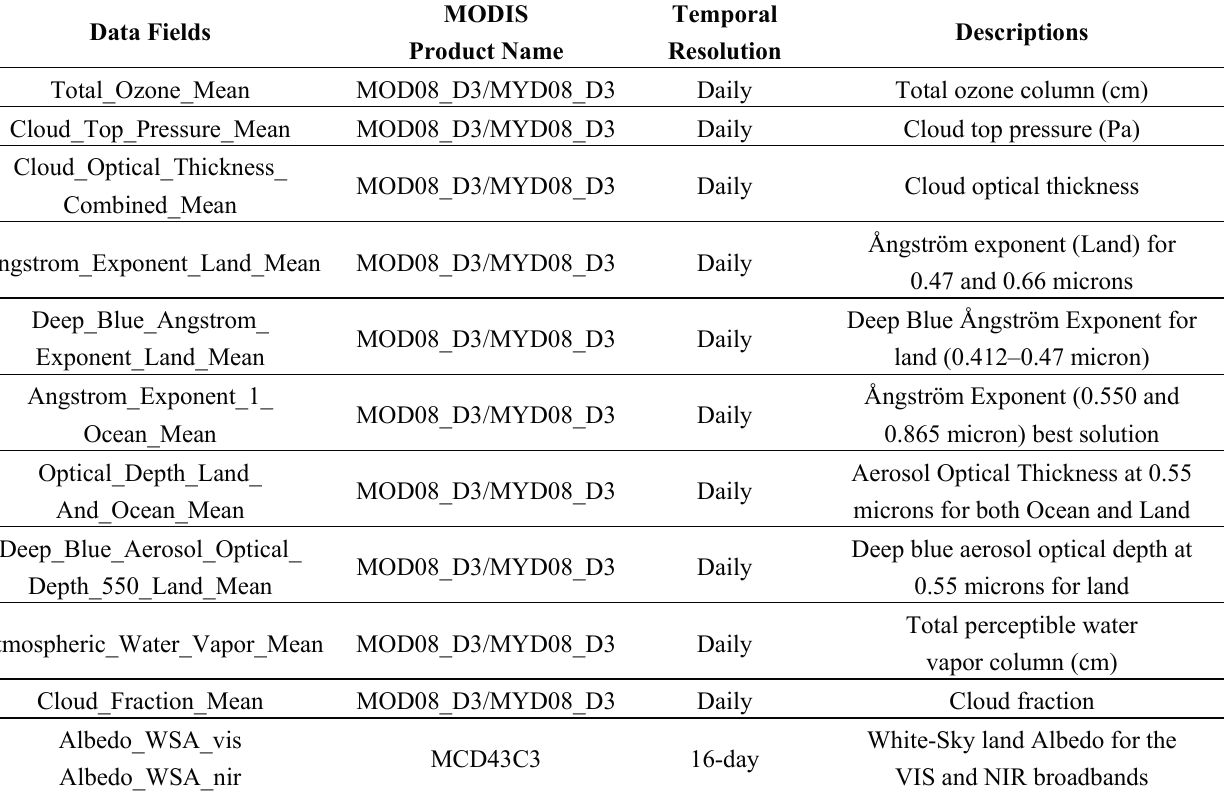
Table 2. MODIS products used in the computing